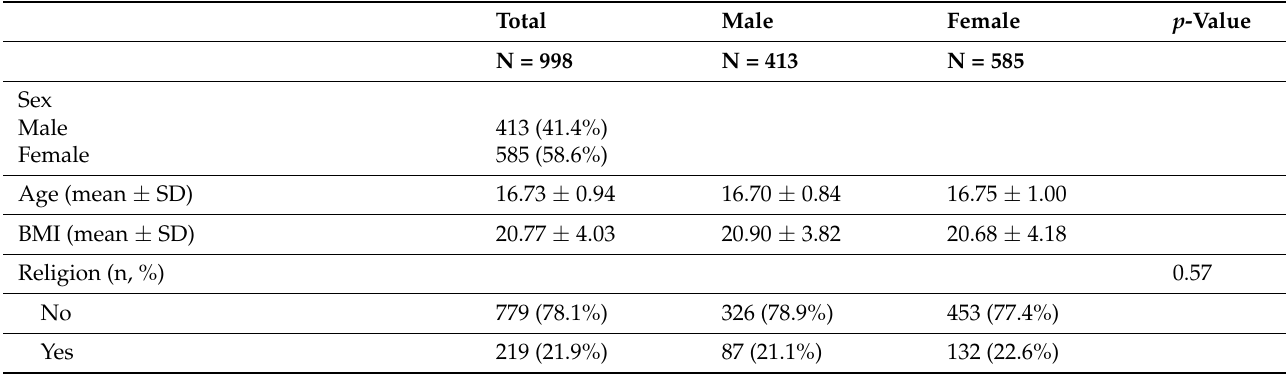
Table 1. Background information of the